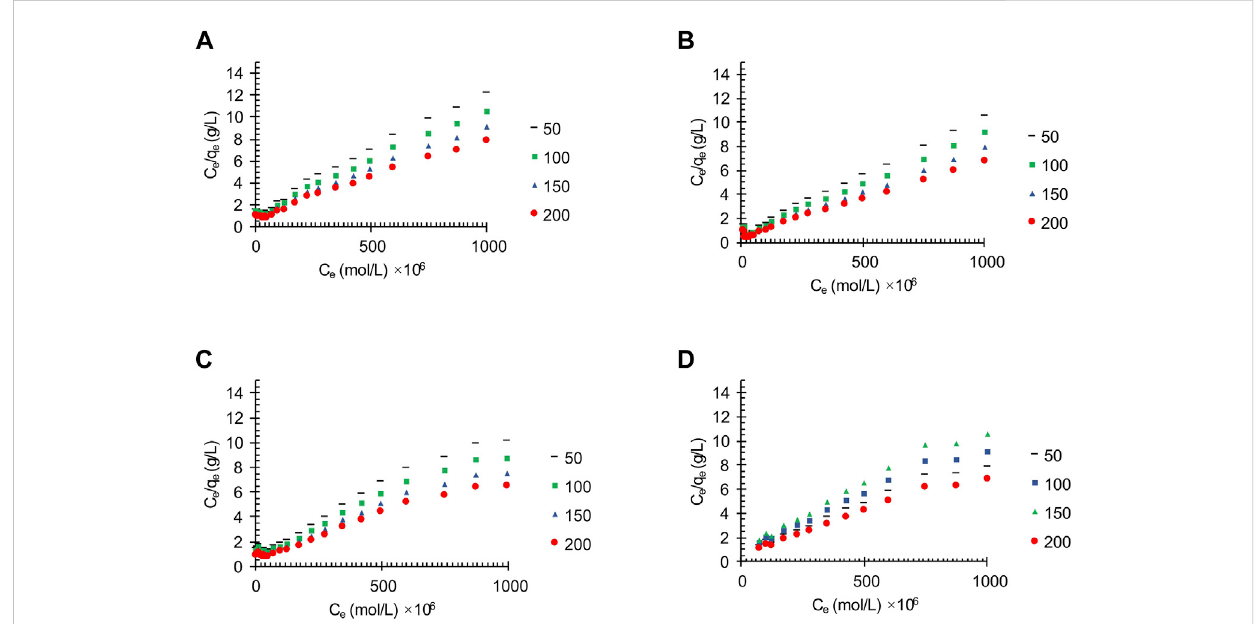
FIGURE 7 The effect of adsorbent amount on the oil adsorption of the synthesized wastewater applying linear Langmuir isotherm on the activated carbon obtained from (A) Oil sludge 1; (B) Oil sludge 2; (C) Oil sludge 3; (D) Oil sludge 4 at T = 318 K and pH = 5.